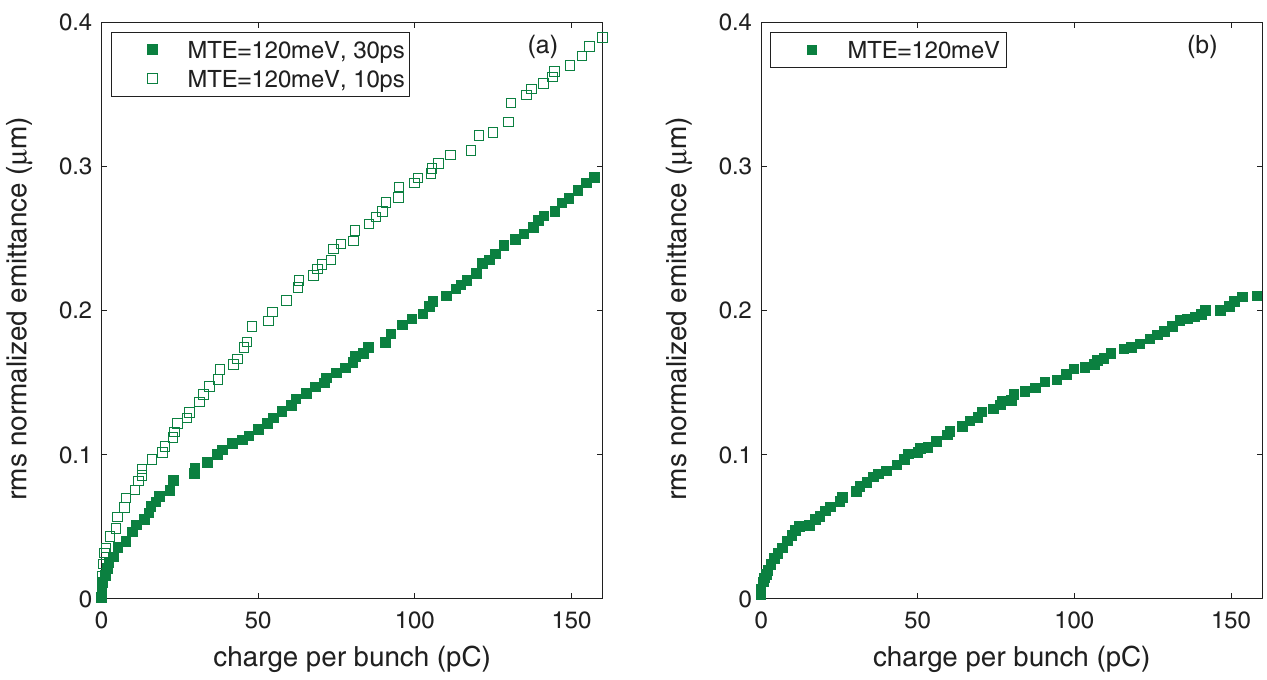
FIG. 13. Emittance at the end of the shortened beam line for (a) dc and (b) SRF guns.